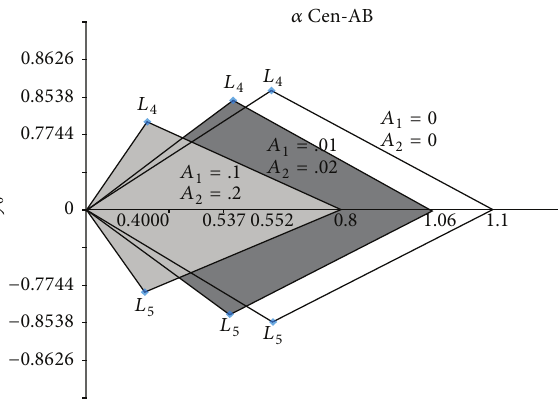
Figure 1: Location of triangular points for Achird.